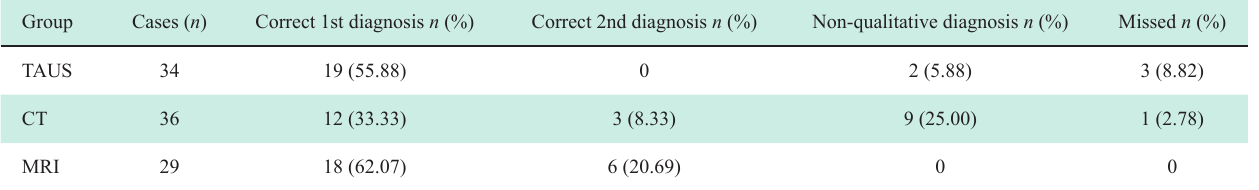
Table 4 Comparison of the qualitative diagnostic efficacy of transabdominal ultrasound, computed tomography, and magnetic resonance imaging Group Cases ( n